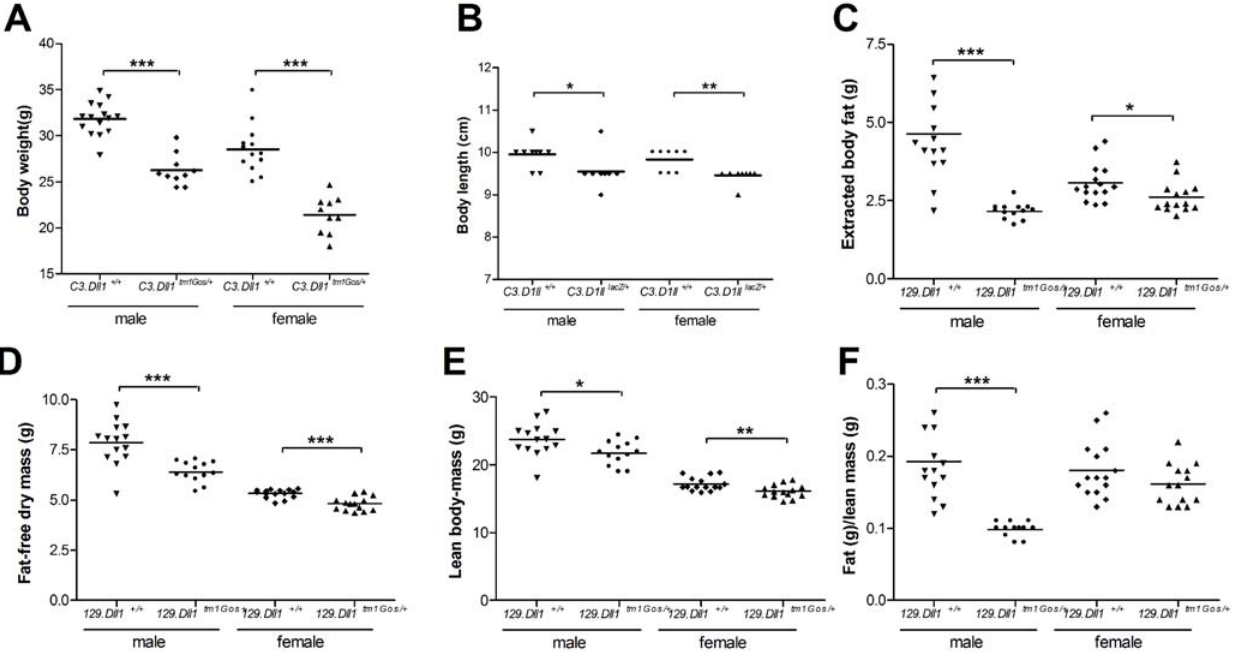
Figure 1. Body weight, size and composition in heterozygous Dll1 tm1Gos/ + animals compared to wild-type littermates. A–B) Body weight and body length were determined at 15 and 16 weeks of age, respectively, in two different cohorts. Depicted are the scatter dot plot representations and the mean for each group: heterozygous C3.Dll1 tm1Gos/ + males (weight, n=13; length, n=9) and their wild-type littermates ( C3.Dll1 + / + , weight, n=15; length, n=10) and heterozygous C3.Dll1 tm1Gos/ + females (n=10) and their wild-type littermates ( C3.Dll1 + / + , weight, n=10; length, n=9). C–F) Selected metabolic parameters were recorded using the Soxhlet lipid extraction with petrol ether as solvent in the tertiary screen at the GMC at 30–32 weeks of age. Depicted are the scatter dot plot representations for and the mean for each group: heterozygous 129.Dll1 tm1Gos/ + males (n=13) and their wild-type littermates ( C3.Dll1 + / + , n=14); heterozygous C3.Dll1 tm1Gos/ + females (n=14) and their wild-type littermates ( 129.Dll1 + / + , n=15). P -value calculated performing unpaired t-test when variances were not significantly different. If significantly different then the